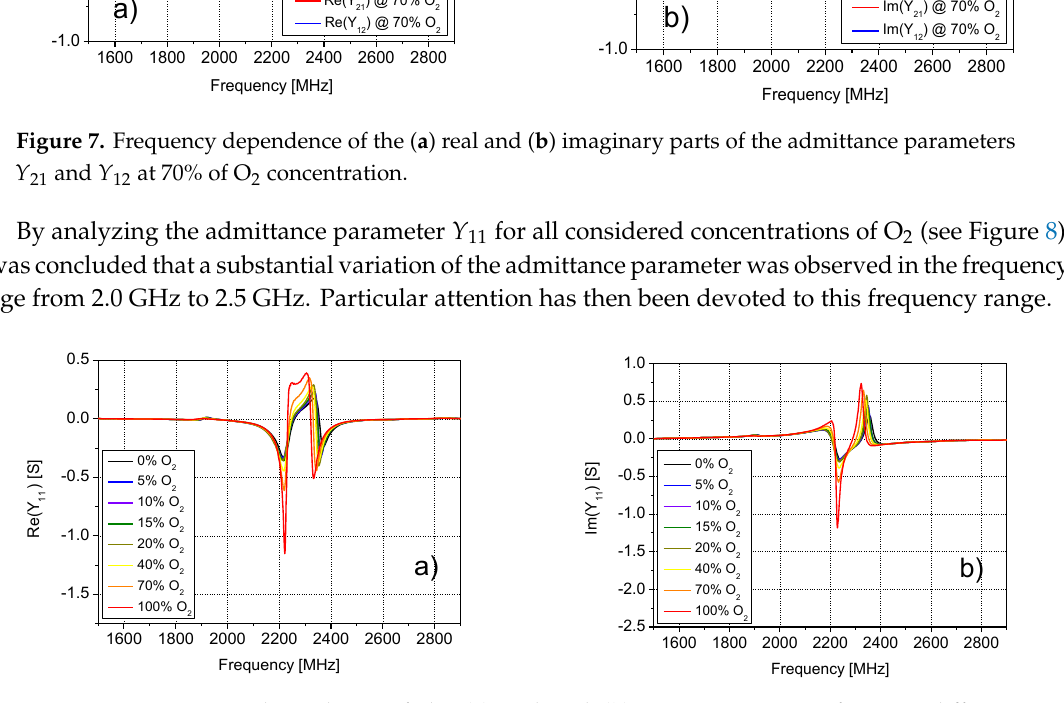
Figure 8. Frequency dependence of the ( a ) real and ( b ) imaginary parts of Y 11 at different O 2 concentrations.